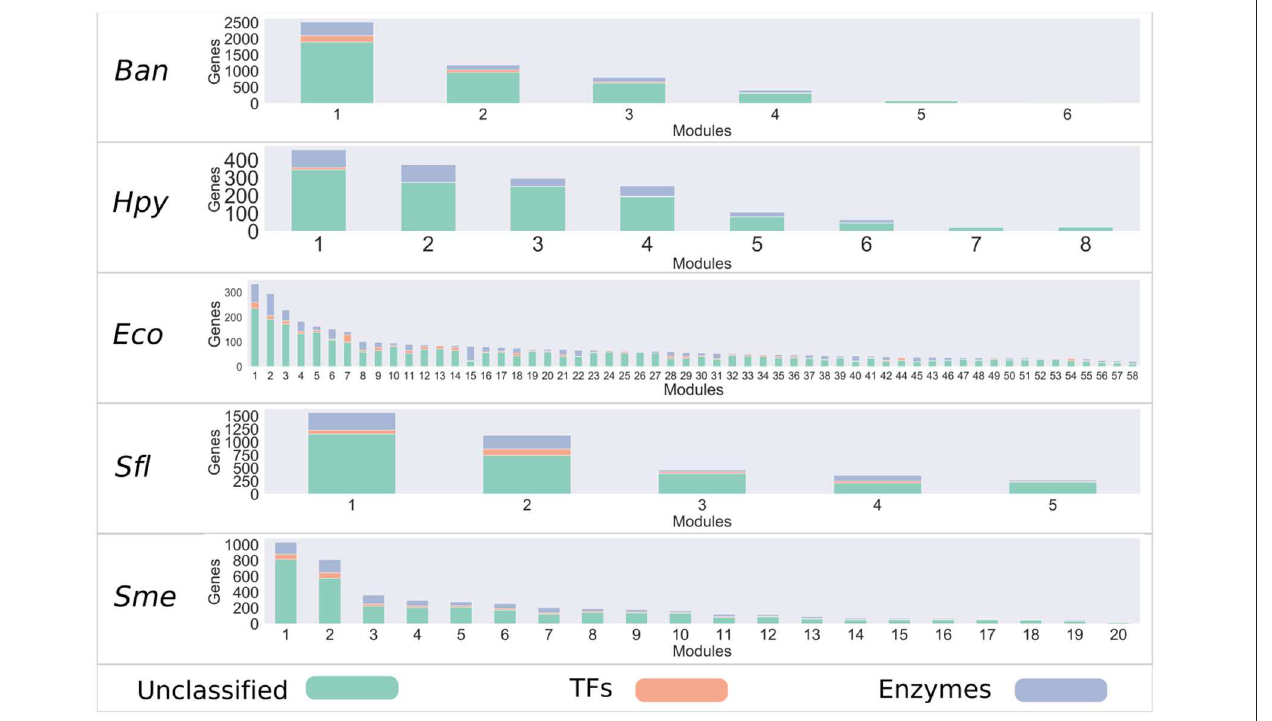
Frontiers in Molecular Biosciences |